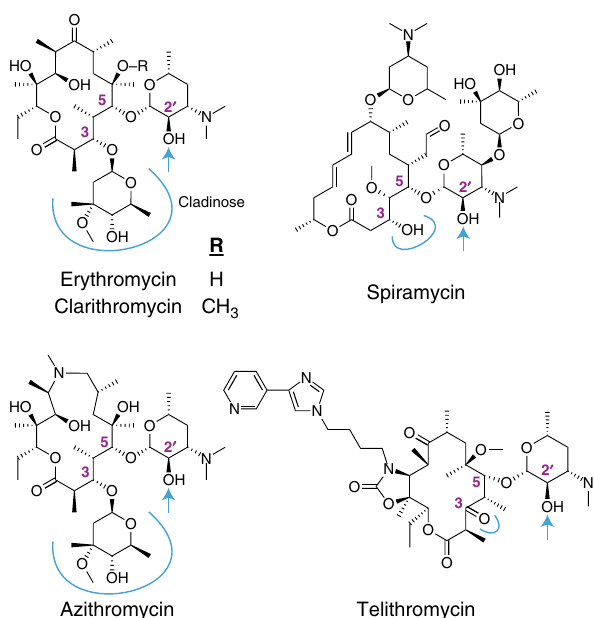
Fig. 1 Structure of macrolide antibiotics. The blue arrow indicates the site of phosphorylation by Mph enzymes. The C3 position is highlighted with a blue